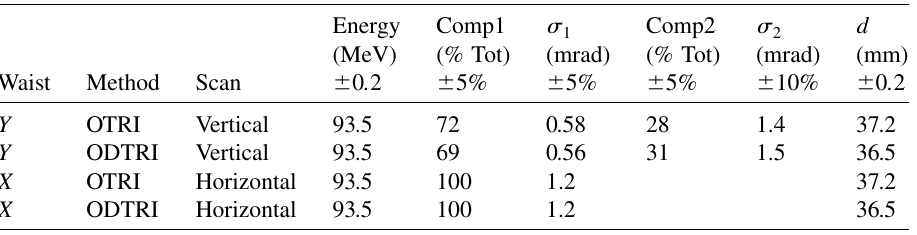
TABLE I. Fitted beam parameters for NPS beam Y and X waists.